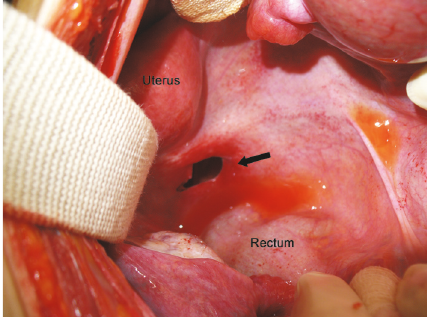
Figure 3: After reduction of the herniated bowel, peritoneal defect between the uterus and the rectum is shown